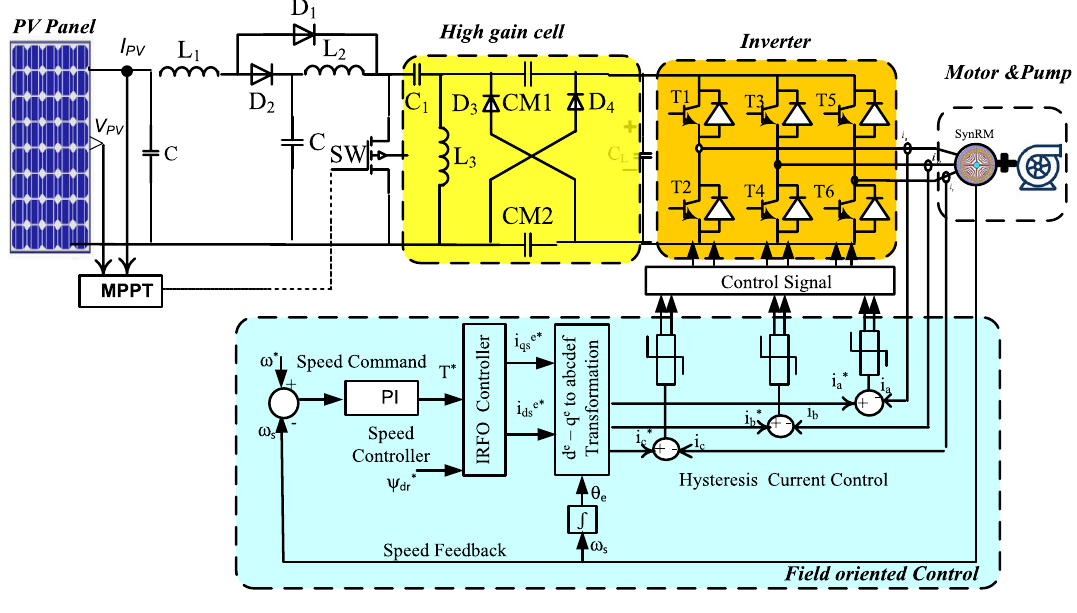
Figure 1. Circuit configuration of the PV high gain converter fed three-phase SYNRM drive system.